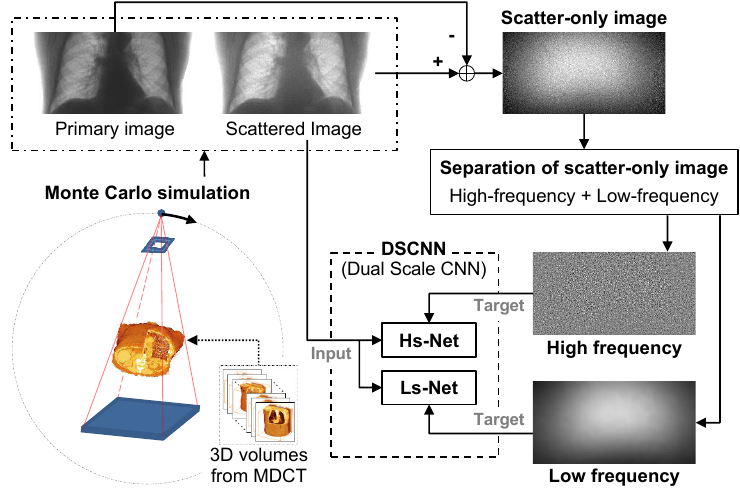
Figure 1. Training process of the proposed scatter correction